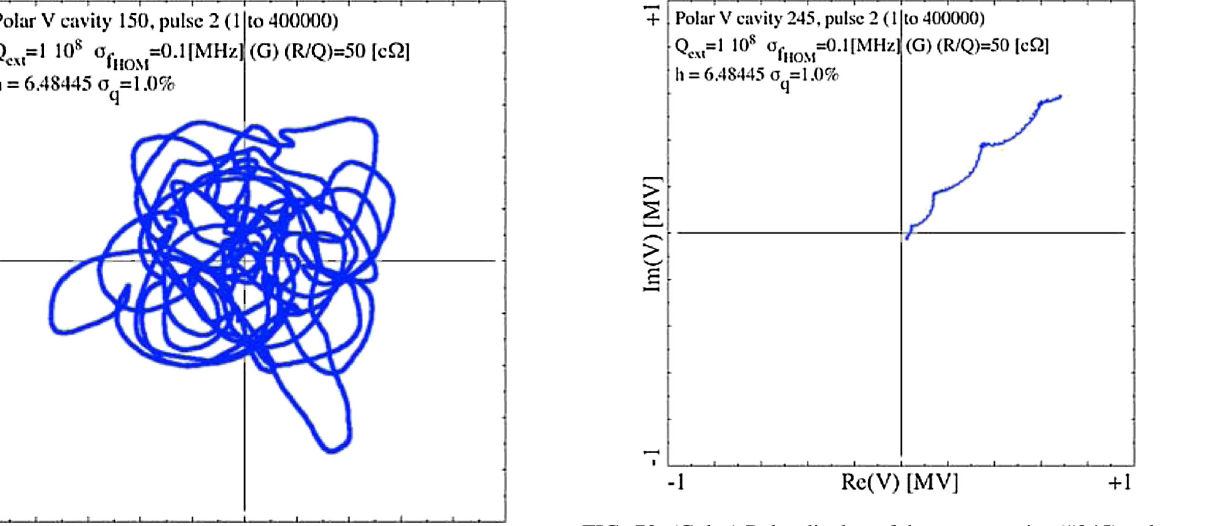
pulse.FIG. 72. (Color) Polar display of the worst cavity (#245) voltage above. There is no real curling showing that this mode is about in phase with the beam modulation.